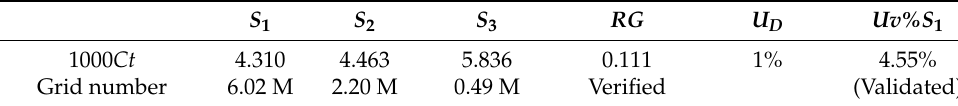
Table 4. Verification analysis for the JBC with the 7 ◦